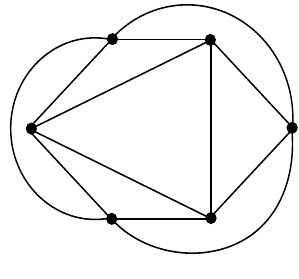
Figure 3. The graph J ( 4,2 )